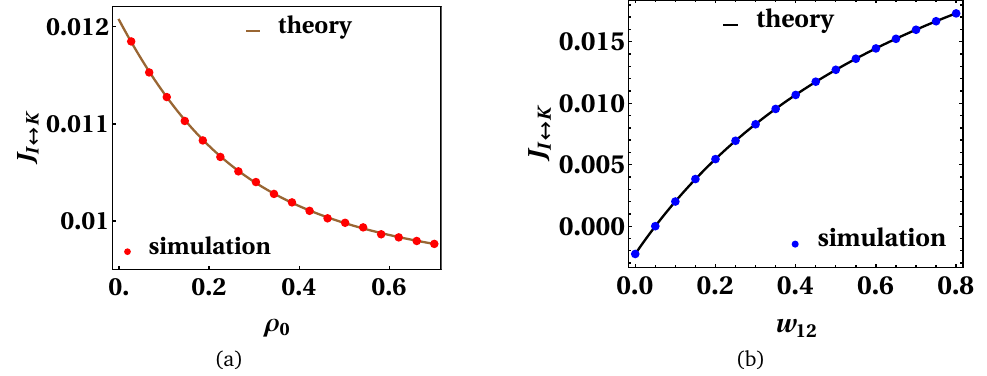
Figure 8: The figures exhibit the variation of the flip current J with va- I ↔ K cancy density ρ and flip rate w in (a) and (b), respectively. The analyti- 0 12 cal and Monte Carlo simulation results show good agreement. The flip current monotonically decreases with increasing ρ whereas it increases monotonically 0 with increasing w . The common parameters for both figures (a) and (b) are 12 = 0.3, p = 1.0, p = 1.0, ε = 0.1, w = 0.5, w = 0.5, w = 0.2, L = 10 3 , p 1 2 3 21 23 32 = 0.8, w = 0.2, ρ = 0.15 . For (a), w = 0.4 and for (b), ρ = 0.22. The w + 31 13 12 0 ensemble average is done over 10 5